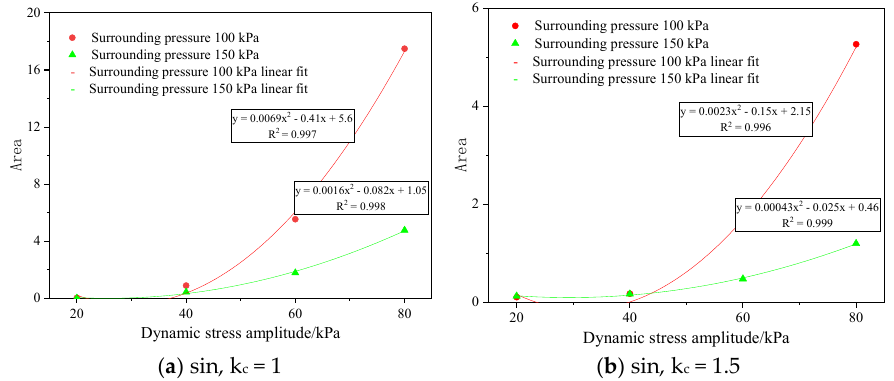
Figure 8. The second-degree parabola fitting of enclosed area for hysteretic curve under different confining